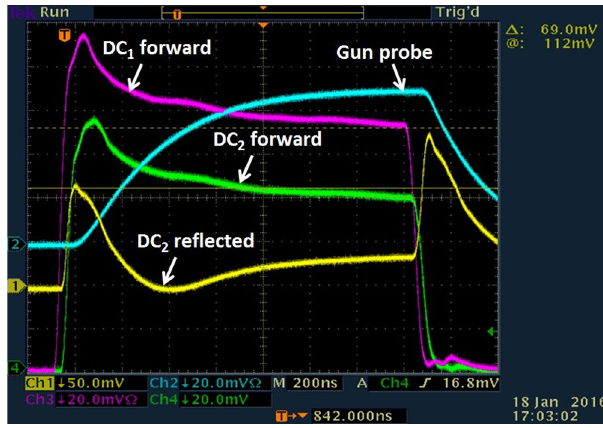
21. rf signals measured during the high power